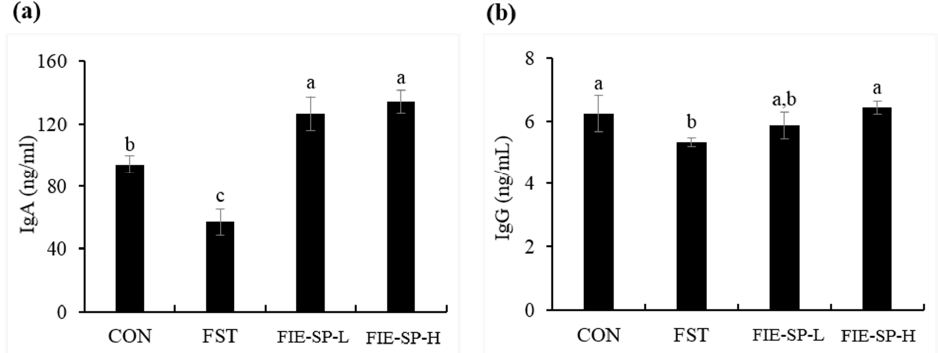
Figure 2. The level of immunoglobulin in C57BL / 6 mouse serum treated with Salvia plebeia extract was determined using ELISA. ( a ) Immunoglobulin A (IgA). ( b ) Immunoglobulin G (IgG). Data are expressed as the mean ± S.E. Di ff erent letters in a column indicate statistical di ff erences based upon Duncan’s multiple range test ( p <